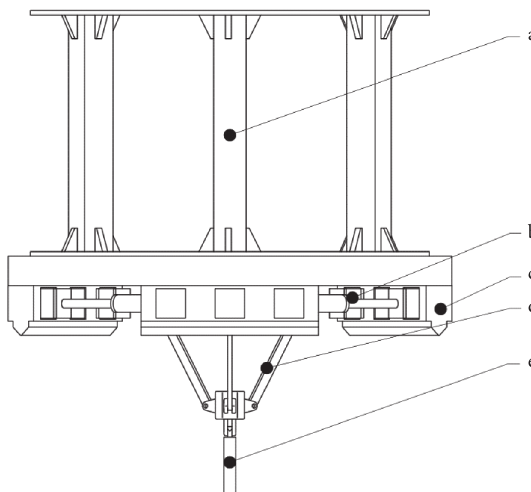
Figure 3: The structure of the machine. (a) Rotary table. (b) Compaction piston rod. (c) Compaction cavities. (d) Connecting rod. (e) Hydraulic cylinder piston